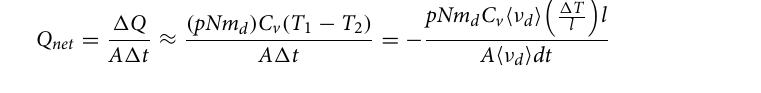
Table 1. Summary of the relative average enhancement ϑ i (%) for each dose. The average was made over 5 values of the thermal conductivity at 25, 30, 35, 40, 45 and 50 °C.